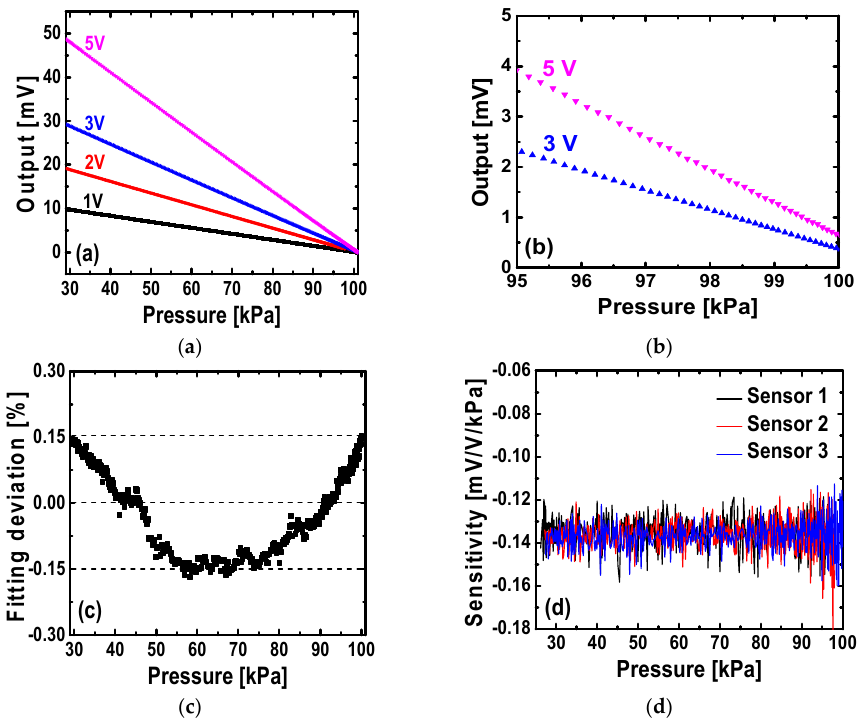
Figure 7. ( a ) Measured output voltages of a pressure sensing element at different input supplies; ( b ) Zoomed-in plot from 95 kPa to 100 kPa at the input voltages of 3 V and 5 V; ( c ) Linear fitting deviation of measured data at the input voltage of 1 V; ( d ) Sensitivity of three sensing elements from different locations on the wafer.